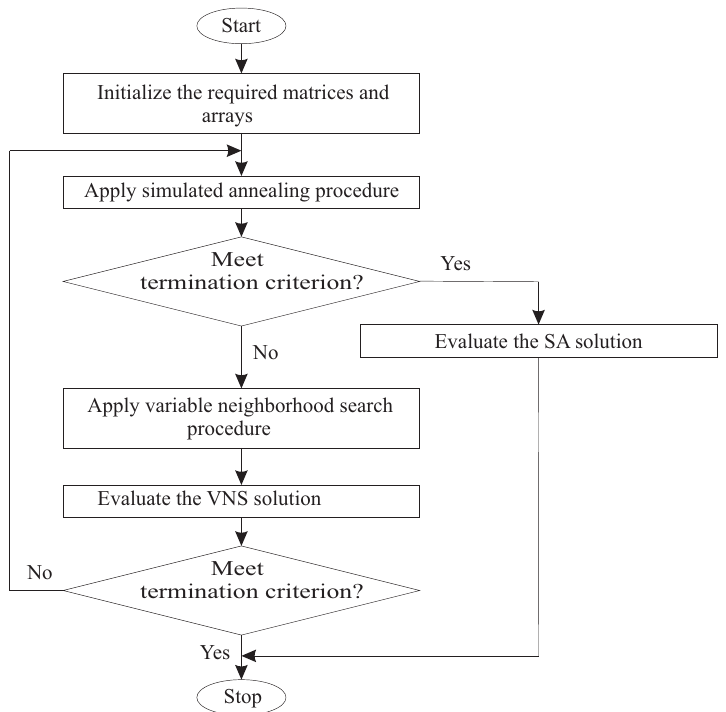
Figure 2. Flowchart of the simulated annealing (SA) and variable neighborhood search (VNS)